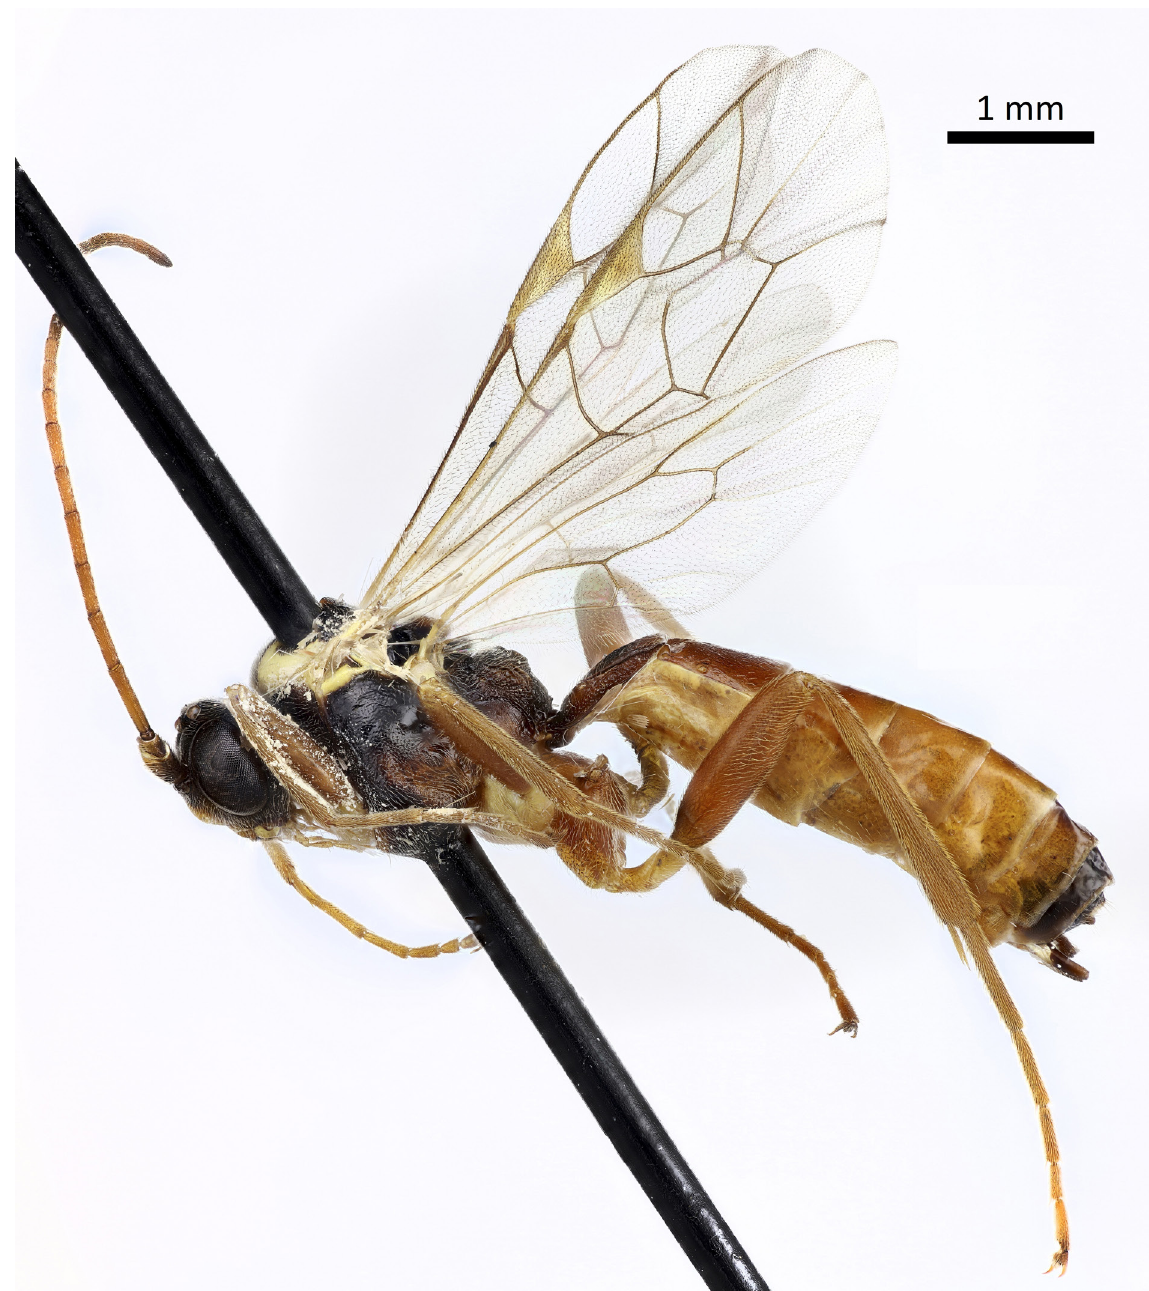
Fig. 7. Homotropus riedeli sp. nov., holotype, ♀ (NHRS-HEVA000011630). Habitus, lateral